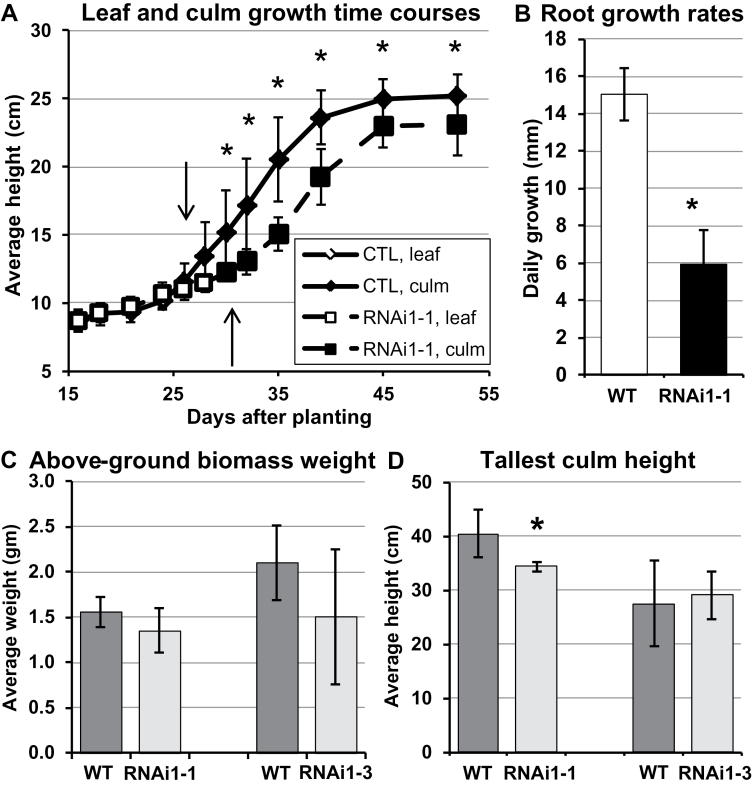
Growth of BdPAL RNAi1-1 and 1-3 plants compared with the WT or empty vector control (CTL). (A) Time course measurements of the longest leaf lengths and tallest culm heights of BdPAL RNAi1-1 plants. Arrows delineate the time points at which 50% of the spikelets could be seen emerging from the leaf whorl. (B) Average daily root growth of BdPAL RNAi1-1 and WT seedlings. n=48. (C, D) Average above-ground senesced biomass dry weight (C) and final culm heights (D). Columns grouped together represent plants grown concurrently. Bars denote the SD. Asterisks represent Student’s t-test significant differences (P<0.03). 5<n<25.